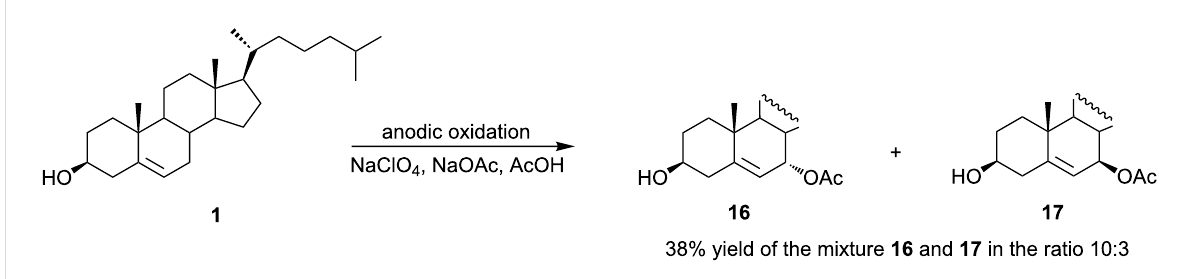
Scheme 7: Direct electrochemical acetoxylation of cholesterol at the allylic position.